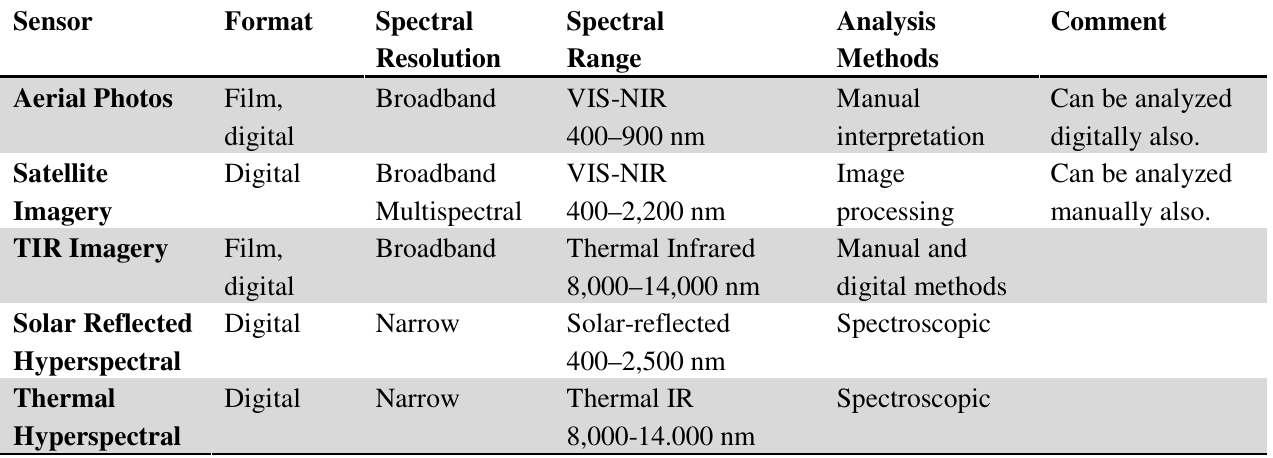
Table 1. Imaging sensors and analysis methods used for hazardous waste analysis and reviewed